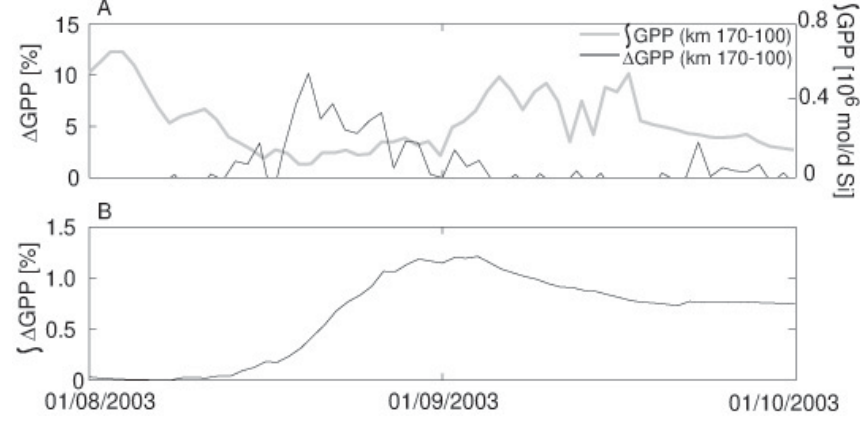
Fig. 12. Temporal evolution of (A) area-integrated (km170–km100) gross primary production R GPP, simulated with the benthic-pelagic model and daily percentage increase of simulated GPP of the benthic-pelagic model compared to the pelagic model 1 GPP. (B) time- integrated percentage increase of simulated GPP of the benthic-pelagic model compared to the pelagic model R 1 GPP.